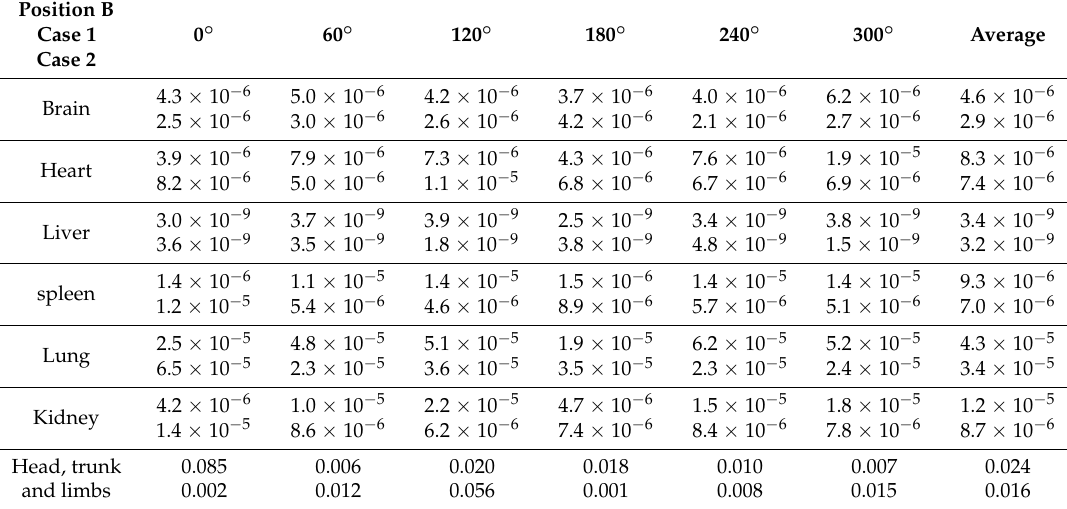
Table 5. The peak spatial-average SAR values (W/kg) in typical tissues with different orientations in position